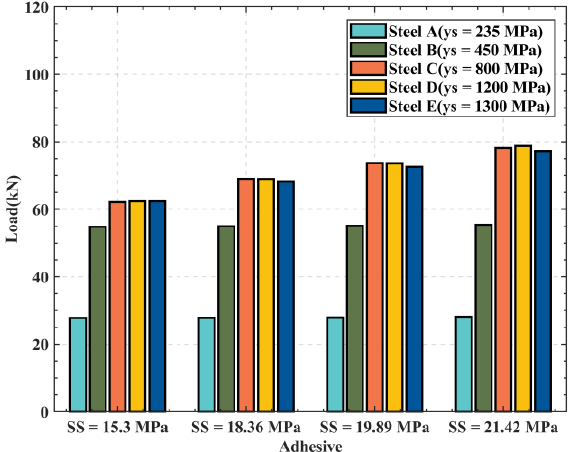
Figure 15. Failure displacement of different anchorage systems.